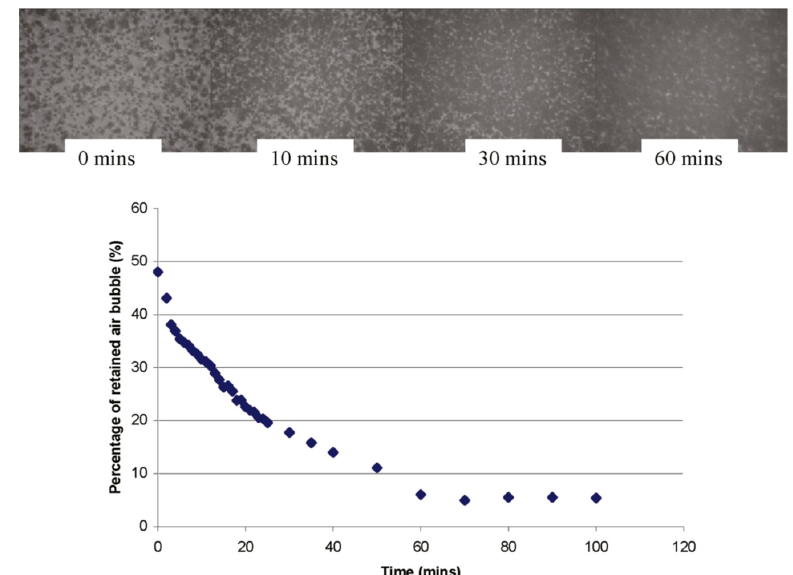
Figure 8. Dynamic wettability of the lotus-mimicked superhydrophobic titanium surfaces immersed in water. Air replacement by water ( top ); graph ( bottom ) showing the percentage of air trapped in superhydrophobic titanium surfaces after 1.5-h immersion in water. (Reprinted with permission from [62]. Copyright 2011 American Chemical Society.)